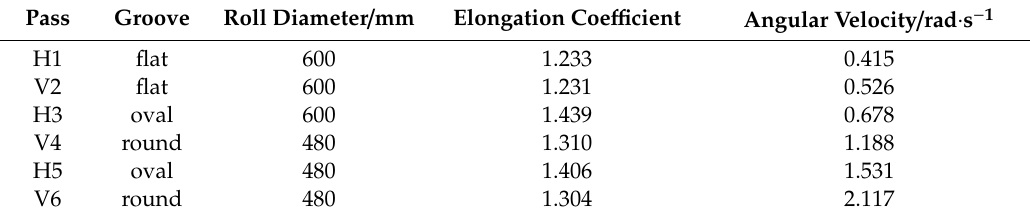
Figure 4. Finite element model of six passes the rough rolling process. Table 3. Technological parameters for the rough rolling process.